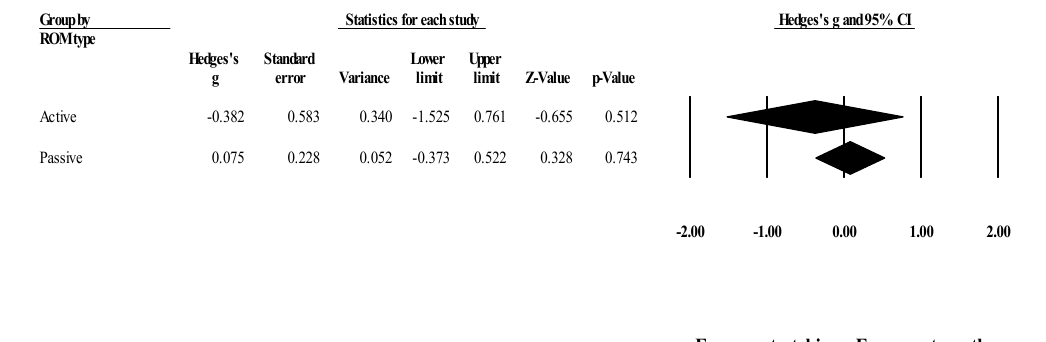
Figure 8. Forest plot of changes in hip flexion ROM after participating in stretching-based compared to strength-based training interventions assessing active or passive ROM. Values shown are effect sizes (Hedges’s g) with 95% confidence intervals (CI).